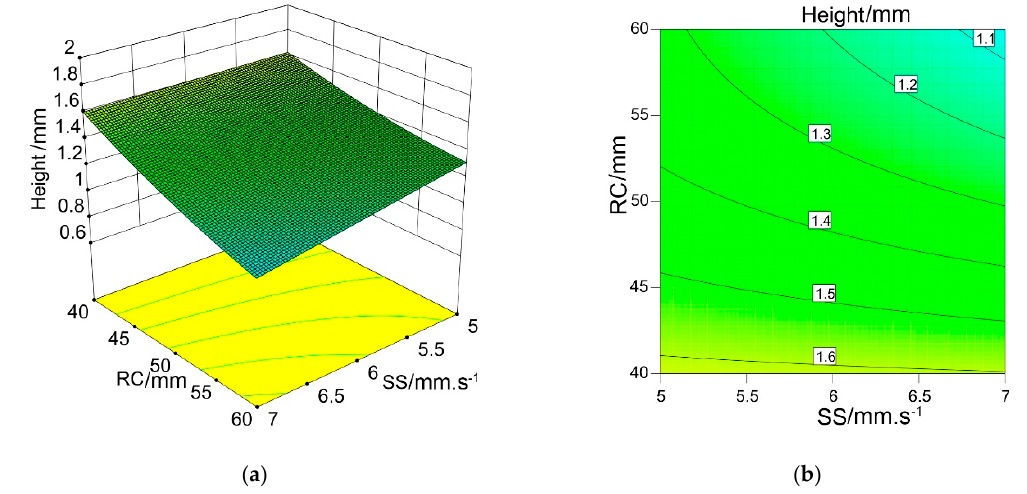
Figure 11. ( a ) 3D response surface showing the influence of scanning speed and outside radius on clad height. ( b ) Contour line of the response surface.